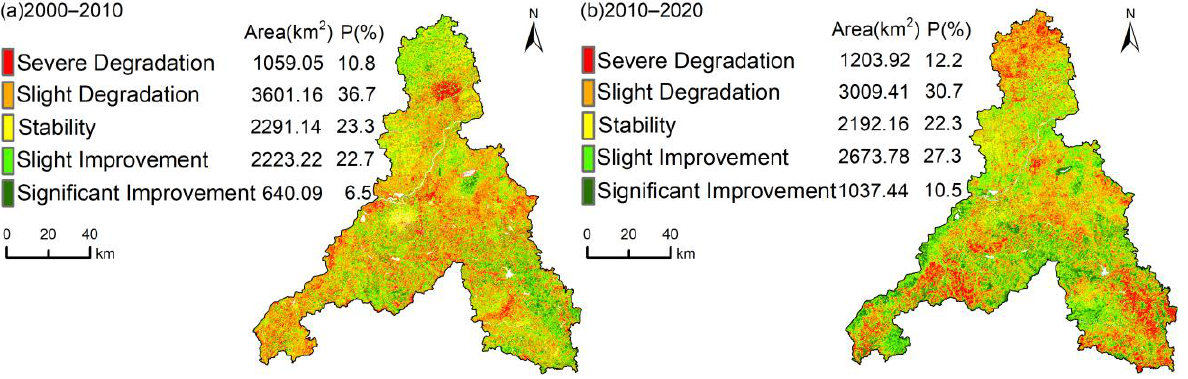
Figure 7. Spatial distribution of ecological quality changes in Jinan from 2000 to 2020: ( a ) shows the